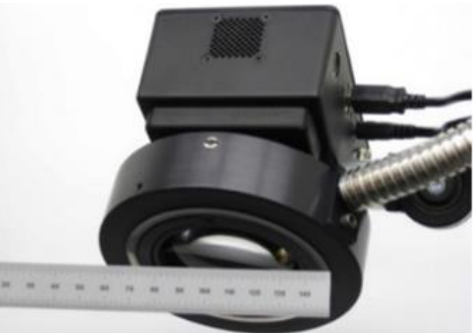
Figure 24. Photograph of a lens plate containing 18 lens assemblies in a hexagonally close-packed array.